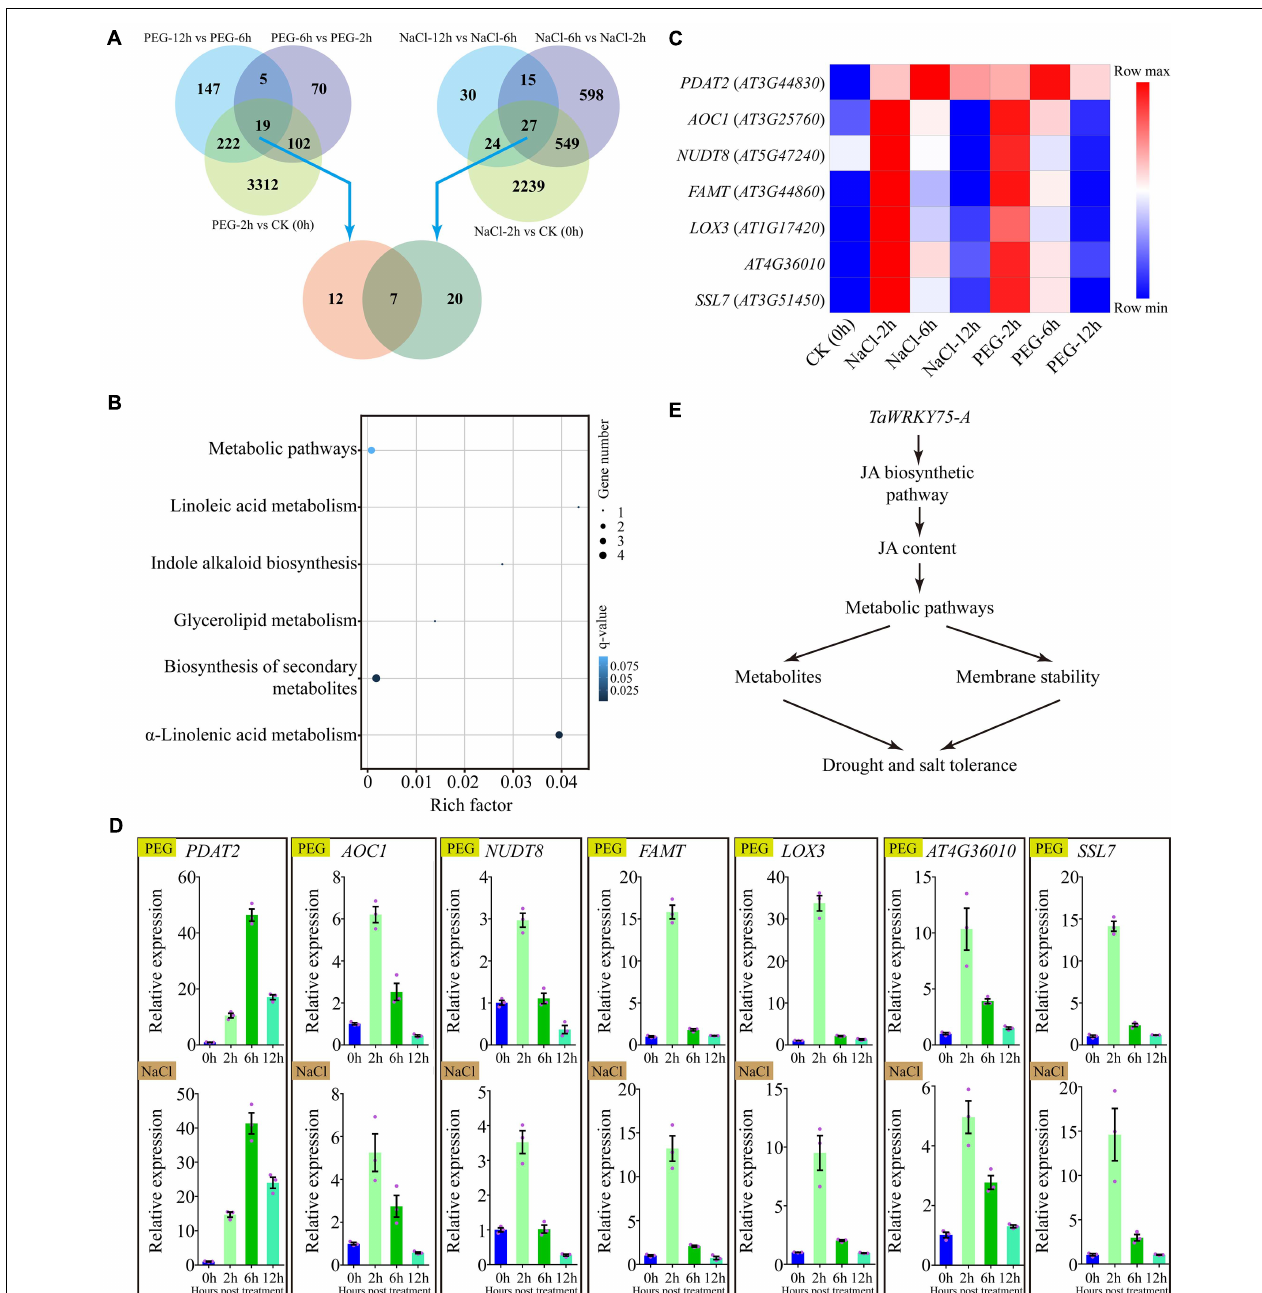
FIGURE 8 | Comparative gene expression using RNA-seq in transgenic Arabidopsis overexpressing TaWRKY75-A after polyethylene glycol (PEG) and salt treatment. (A) Differentially expressed genes (DEGs) in TaWRKY75-A Arabidopsis after PEG or salt treatment compared across different time points of each treatment (top) for 0 (CK), 2, 6, and 12 h. A comparative analysis of DEGs between PEG and salt treatments was also conducted (bottom). (B) Kyoto Encyclopedia of Genes and Genomes pathway enrichment of seven common DEGs isolated from PEG and salt treatments in (A) . (C) Expression heat map of seven common DEGs after salt or PEG treatments. (D) qRT-PCR results of seven common DEGs after PEG (top) or NaCl (bottom) treatments. All experiments were replicated three times. Bars indicate means ± SD. The relative expression levels were normalized with Arabidopsis ACTIN2 gene (AT3G18780). (E) The proposed working model of TaWRKY75-A regulating drought and salt tolerance. TaWRKY75-A can regulate the expression of jasmonic acid (JA) biosynthetic enzyme-encoded genes to change the JA content under drought and salt stresses. The downstream genes, which take part in several metabolic pathways, make a fast response to JA, resulting in the alterations of membrane stability and metabolites in cells. These alterations afford drought and salt tolerances in wheat and transgenic Arabidopsis .